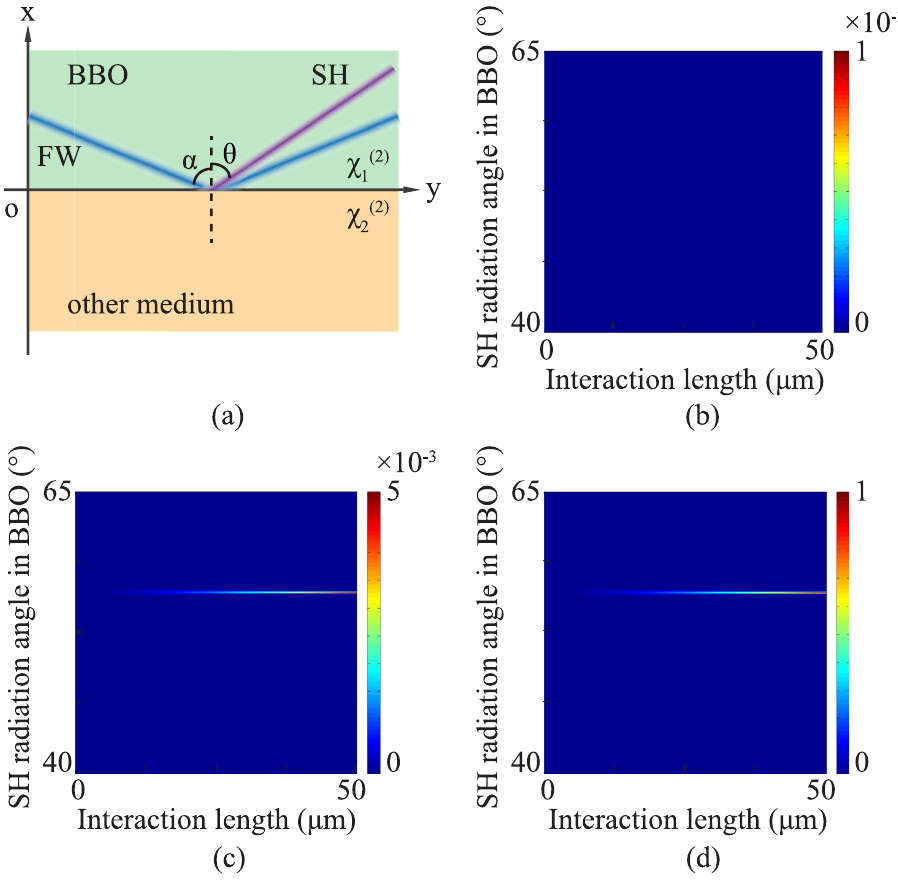
Figure 2. ( a ) Diagram of SH generated at the interface of BBO ( χ 1(2) ) and another medium ( 2(2) χ ). ( b ) Simulation result under the condition χ χ = 1(2) 2(2) which presents a homogeneous nonlinear coefficient environment. ( c ) and ( d ) are distributions of SH generated on BBO boundary ( χ = 0 2(2) ) and the interface of BBO and LN ( 13 2(2) 1(2) χ χ = ), respectively. The colors indicate the intensities of SH. The radiation angle of these two cases is the same and the intensity in ( d ) is higher than that in ( c